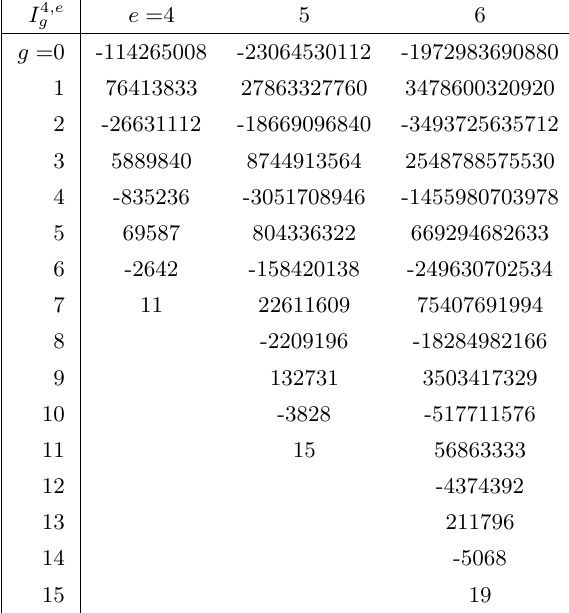
Table 11 . Unrefined BPS indices I n b ,n e